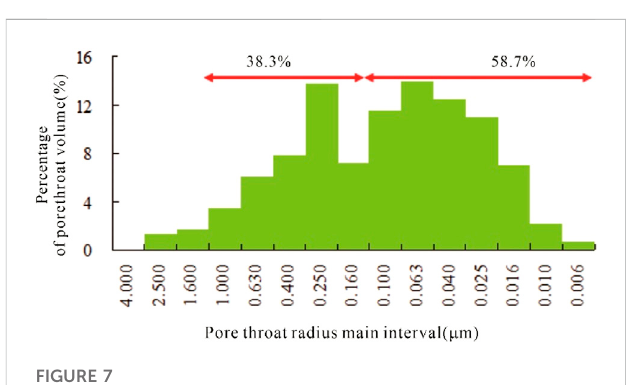
FIGURE 7 Distribution of the pore throat radius in the Gaotaizi reservoir in the Qijia